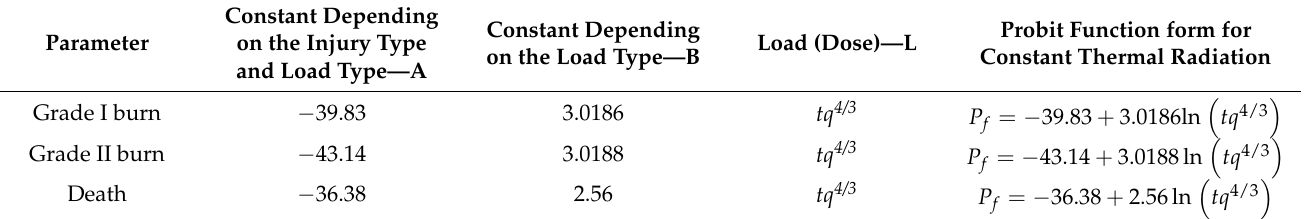
Table 1. Forms of probit functions for heat flux impact effects [9], where: t —exposure duration [s]; q —heat load [W/m 2 ].